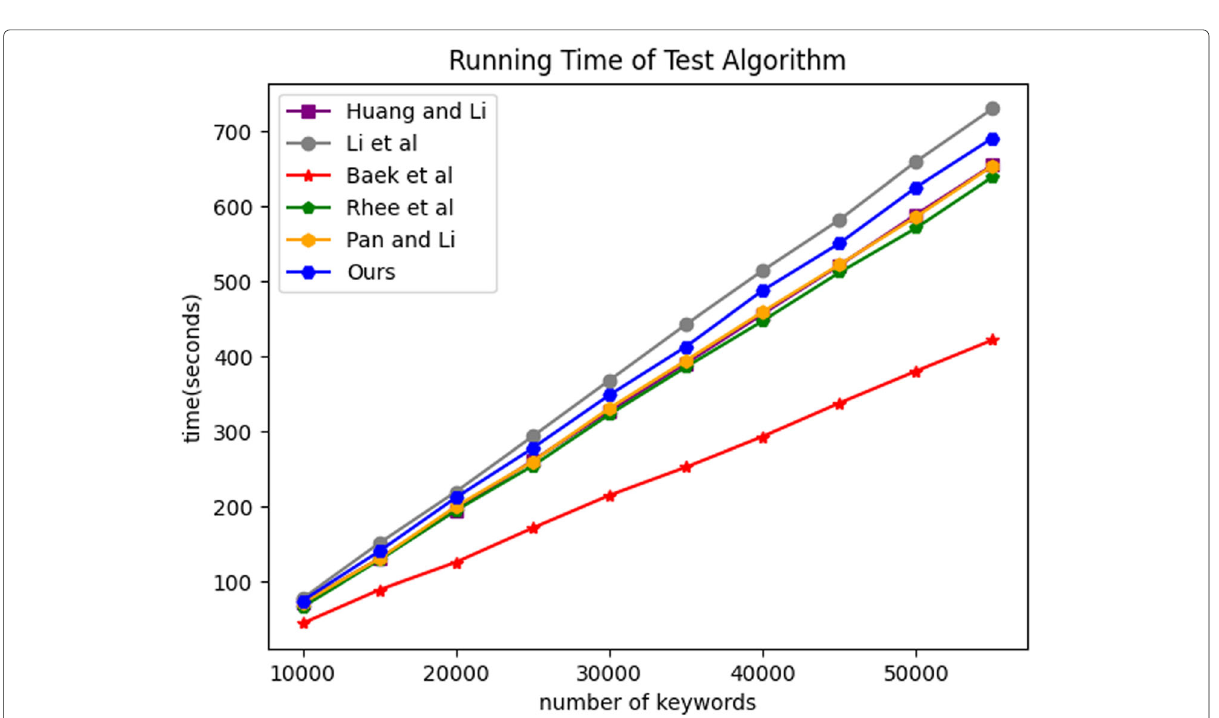
Fig. 4 Running Time of Test